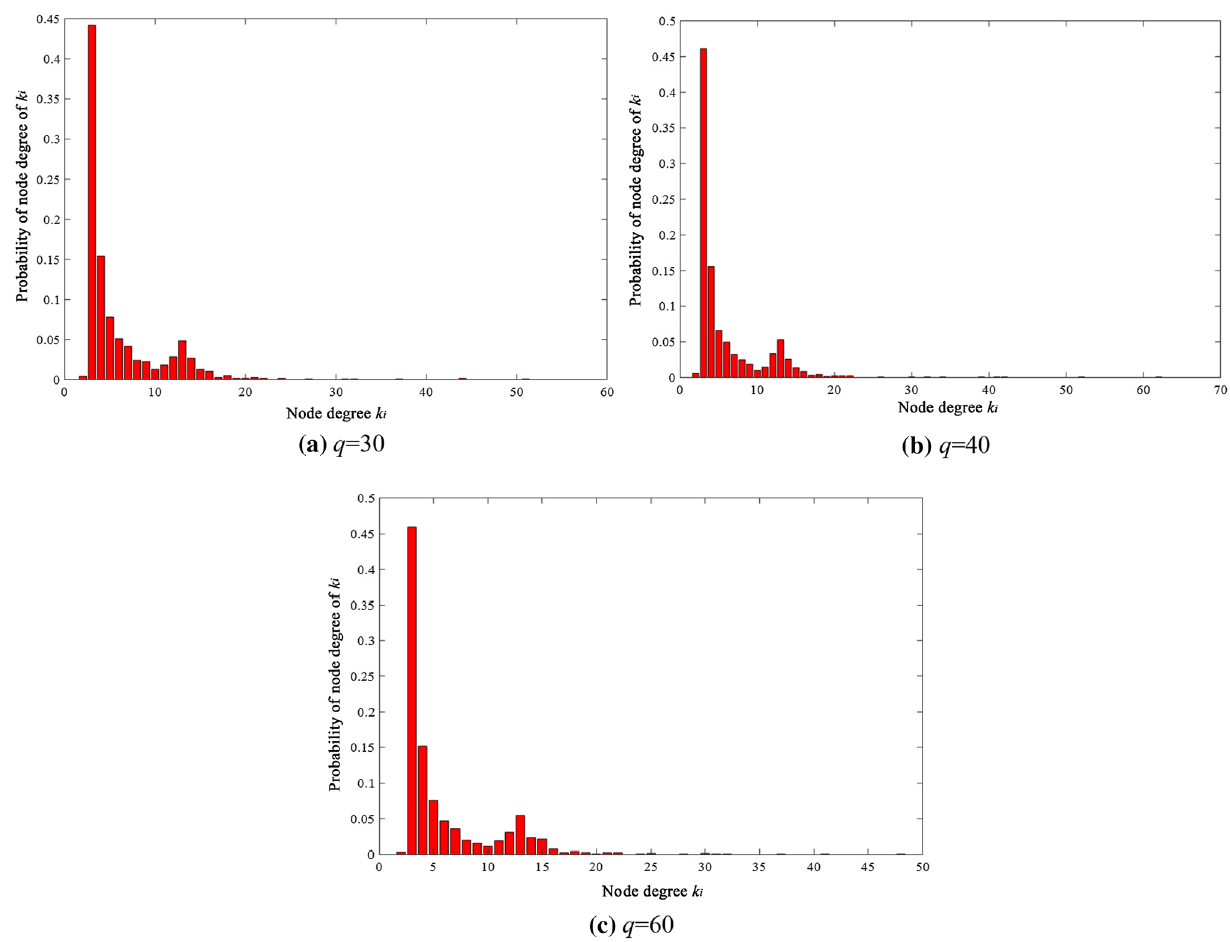
Fig. 8 Probability distribution of node